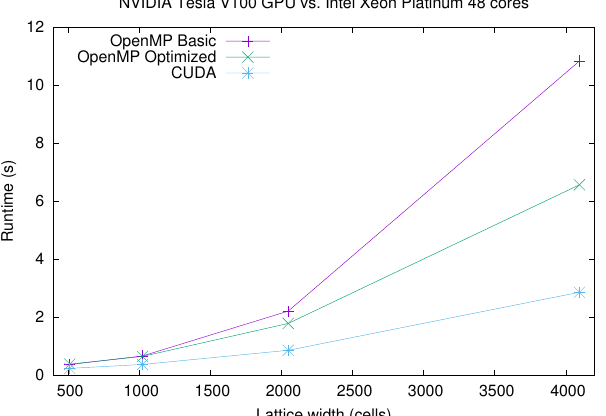
Figure 6. Runtime comparison between NVIDIA Tesla V100 GPU and Intel Xeon Platinum (dual socket with 48 cores in total) for different CA lattice sizes.